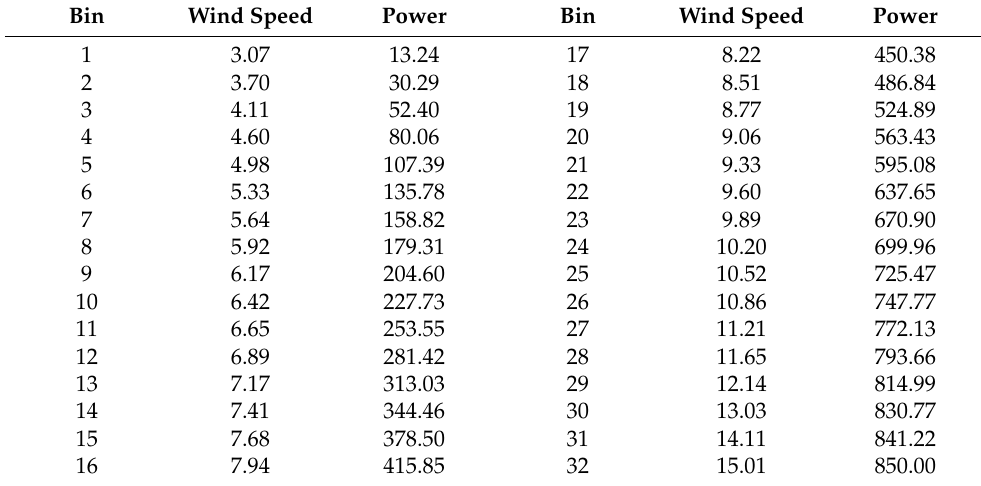
Table 3. Data aggregation equivalent point.